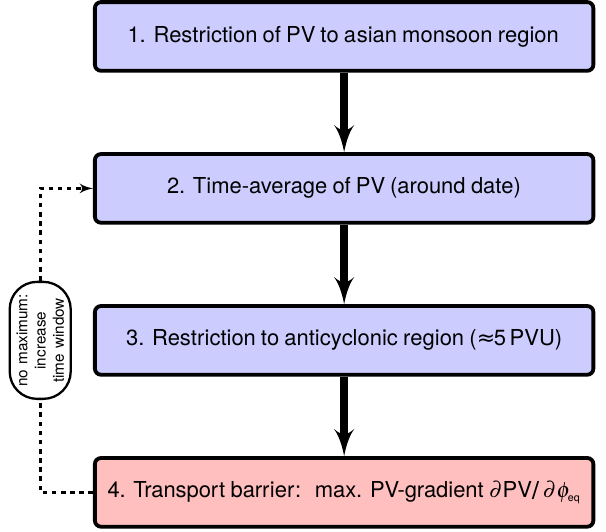
Figure 9. Method to localize the PV-based transport barrier in the Asian monsoon anticyclone (at 380K), summarized in four steps.